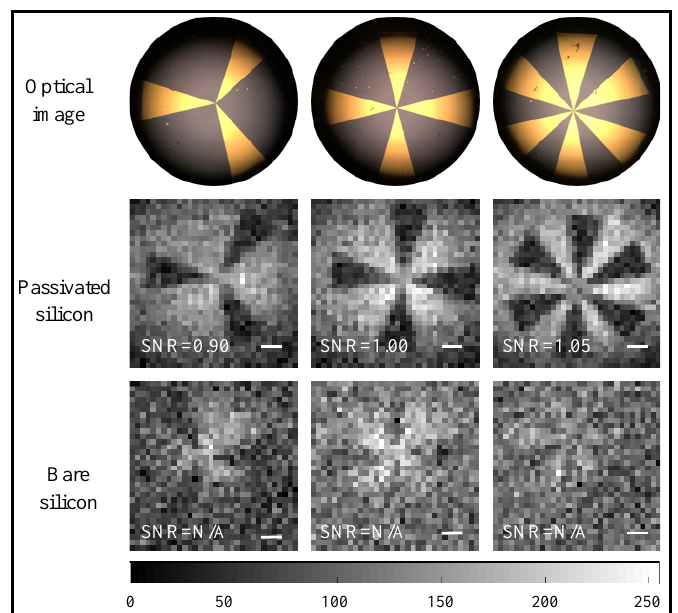
Figure 4. Top panel: optical images of three targets. Middle and bottom panels: reconstructed 32 × 32 terahertz images ( N = 32) based on photomodulators made of passivated and bare silicon wafers, i.e., samples S5 and S0, respectively. The images were reconstructed under full sampling. The scalar bars denote 500 µ m.